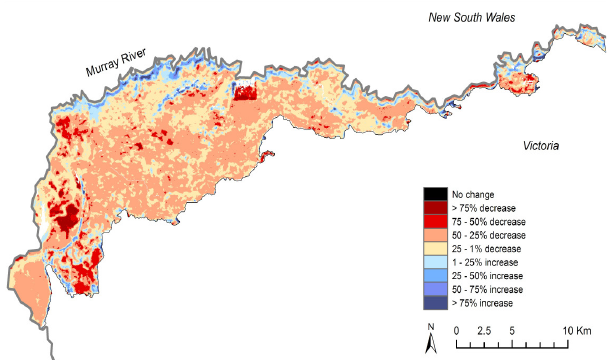
Figure 2. Change in ETrF between 27/11/1993 and 3/11/2008